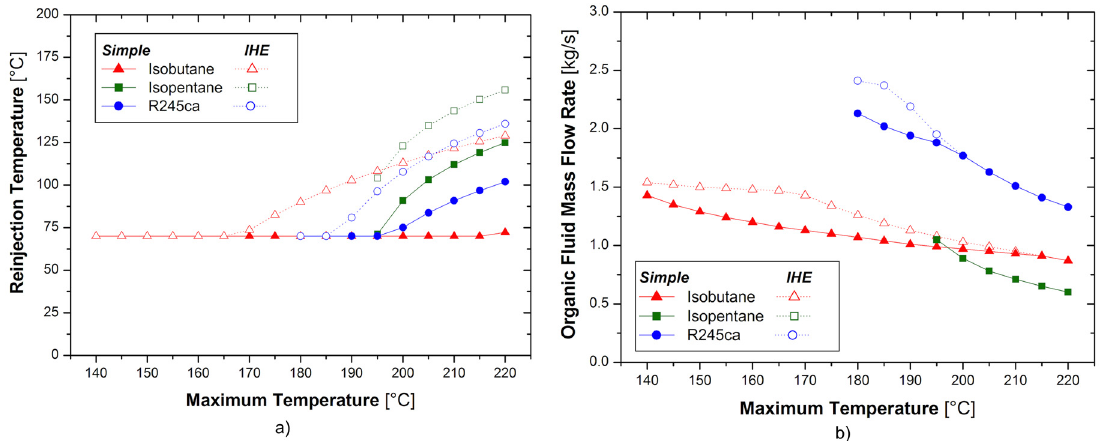
Figure 10. Effect of maximum temperature on geothermal reinjection temperature ( a ) and mass flow rate of organic fluid ( b ) (transcritical cycle). Table 3. Main performances of selected ORC systems.